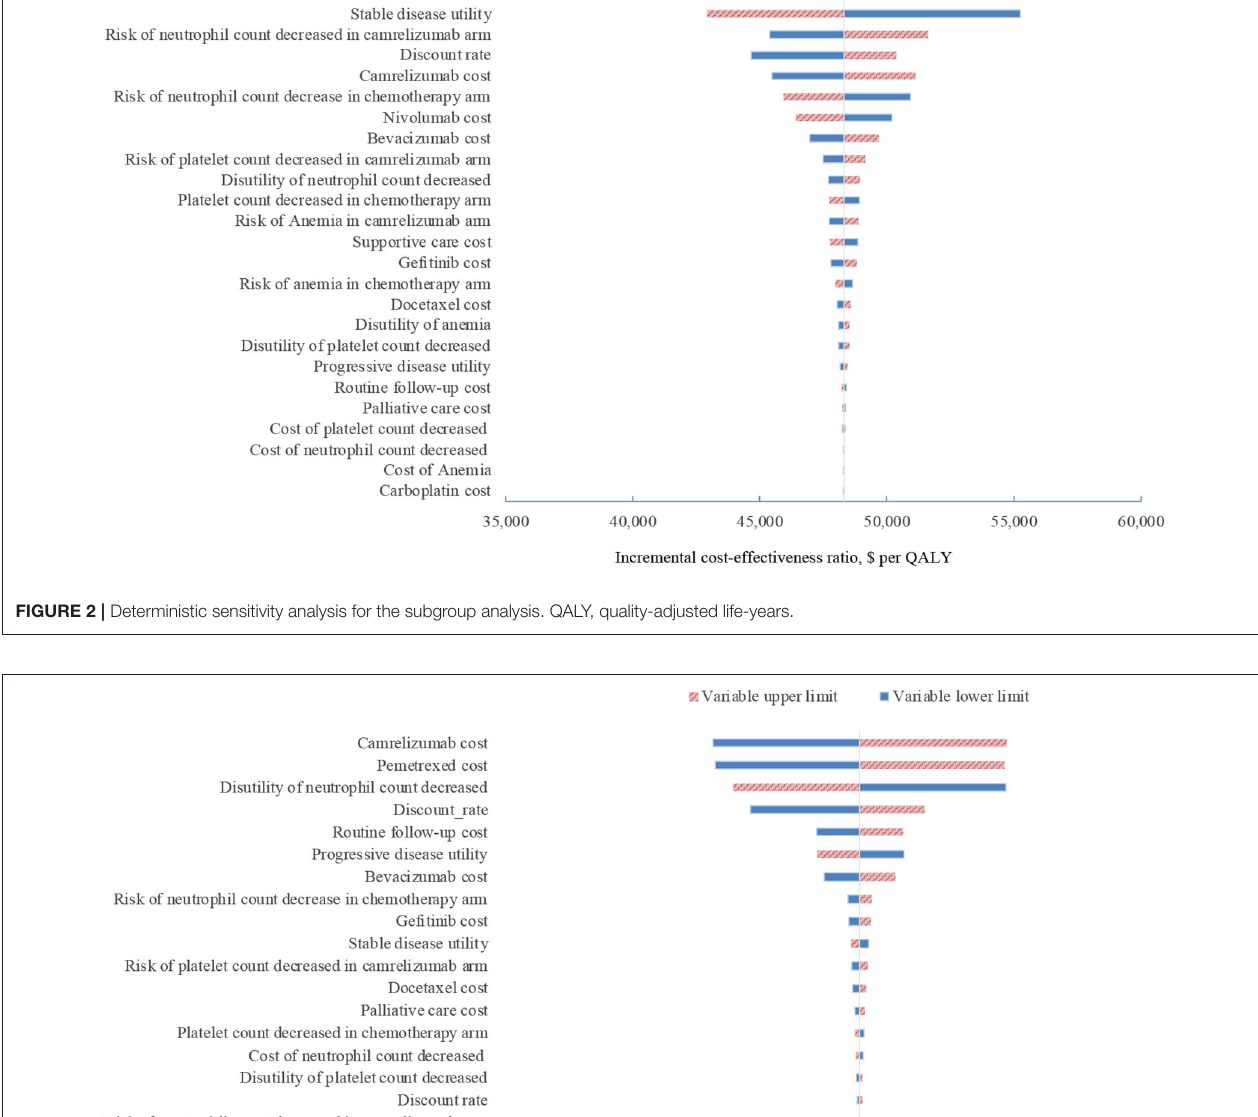
that, in patients with PD-L1-expressing tumors, camrelizumab combination therapy failed to cross the threshold of WTP again despite a more favorable cost-effectiveness associated with an increased incremental QALY compared to the base case. Due to ethical issues, the base case analysis included